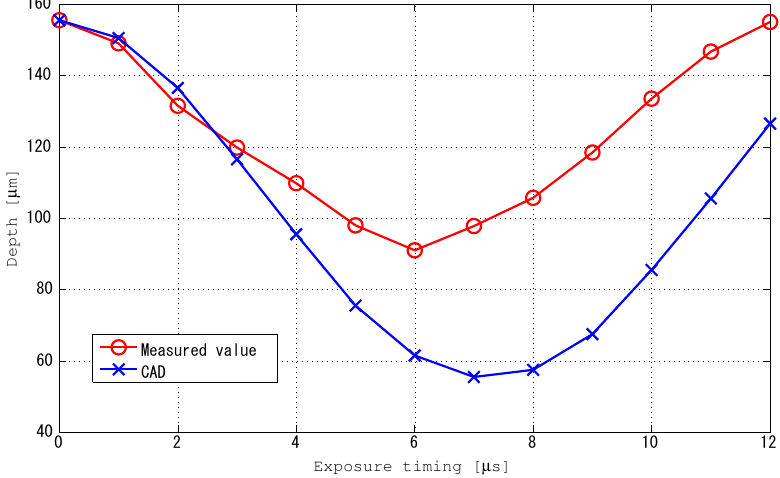
Figure 6. Measurement results for change in focal